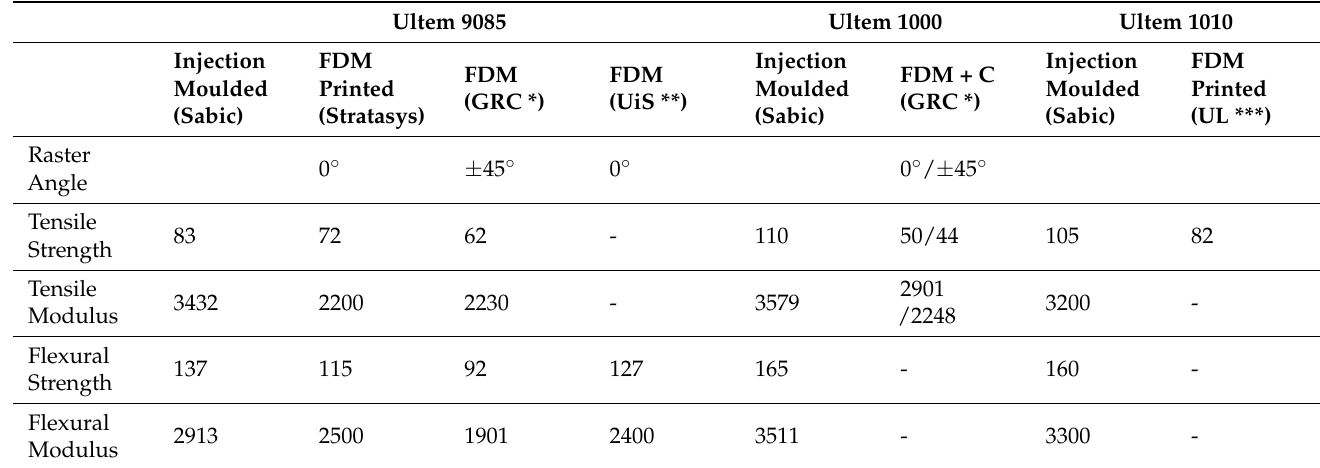
Table 3. Mechanical properties of ULTEM series (units in MPa)